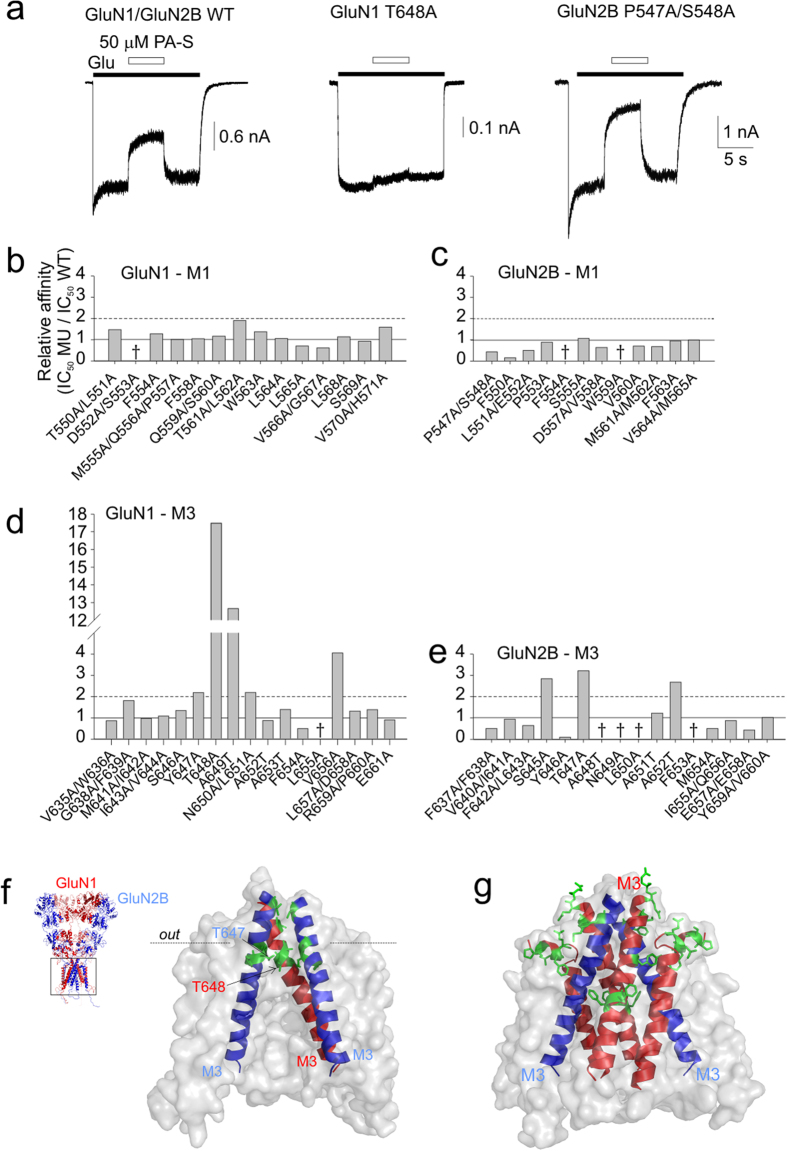
Mutations in the M1 and M3 regions of the GluN1 and GluN2B subunits alter the inhibitory potency of PA-S.(a) A representative response is shown for WT and mutated GluN1/GluN2B receptors. Responses mediated by GluN1(T648A)/GluN2B receptors were assessed as a difference between the current recorded in the presence of 1 mM Mg2+ (condition that abolished the spontaneous currents) and that recorded in the presence of 1 mM glutamate and 10 μM glycine. While the GluN1(T648A)/GluN2B receptors were only slightly affected by PA-S (50 μM) when compared to the WT receptor, the GluN1/GluN2B(P547A/S548A) receptors were more sensitive to the steroid. Graph of the relative PA-S affinity for NMDARs mutated in the M1 regions of GluN1 (b) and GluN2B (c) or mutated in the M3 regions of GluN1 (d) and GluN2B (e) are shown. Relative PA-S affinity was determined as the ratio of PA-S IC50 (Equation 1) determined for mutated receptors and the IC50 for the WT receptor (42 μM; n = 20). † indicates a non-responding mutation, i.e. a minimum of six GFP-positive cells responding to 1 mM glutamate application with currents <20 pA. (f) Amino acid residues whose mutations altered PA-S inhibition are depicted in a homology model of GluN1/GluN2B. For clarity, only the transmembrane region is shown. GluN1 is colored in light blue and GluN2B is colored in light red. Dashed line indicates the boundary between hydrophobic and hydrophilic regions of lipid as determined by the OPM database63. Residues whose mutation to alanine increased the IC50 for PA-S inhibition of GluN1/GluN2B receptor responses more than two–fold (to >84 μM) are highlighted in green. (g) Residues whose mutation to alanine decreased the IC50 for PA-S inhibition by half (to <21 μM) are highlighted in green.